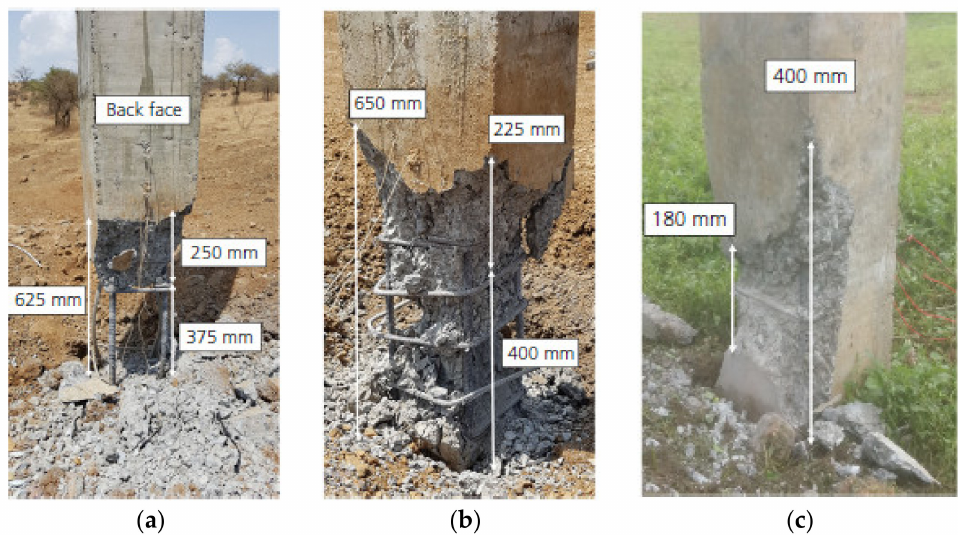
Figure 15. Column damages after blast loads: ( a ) 1 kg; ( b ) 0.5 kg and ( c ) 115 g TNT [27]. Copyright permission obtained from